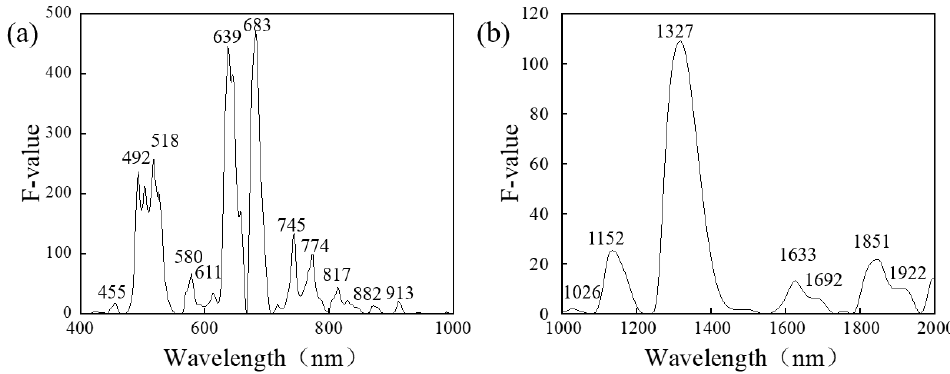
Figure 4. ANOVA results of SNV pre-treated spectra in the band range of ( a ) 400–1000 nm and ( b ) 1000–2000 nm.